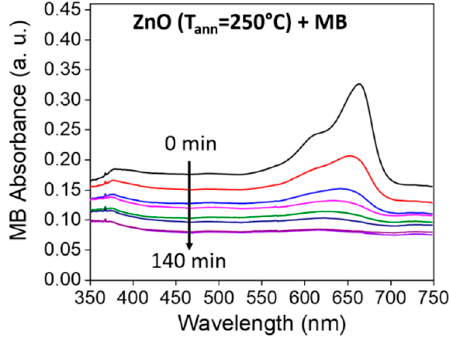
Figure 9. Optical absorption spectra showing the evolution of MB absorption in the presence of ZnO catalyst (annealed at 250 °C) under different irradiation times lasting for 140 min.